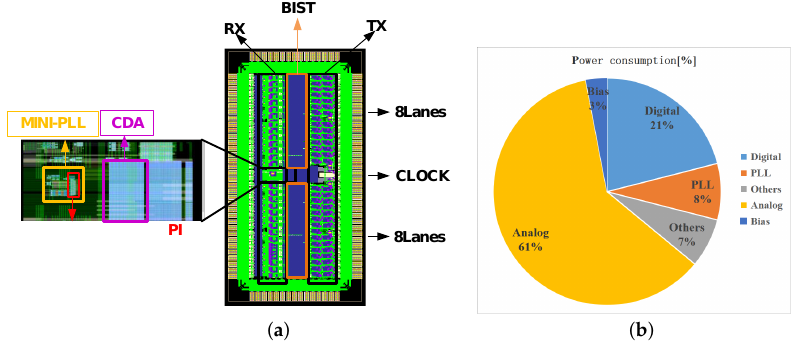
Figure 23. ( a ) Layout design, ( b ) power consumption ratio of each module in